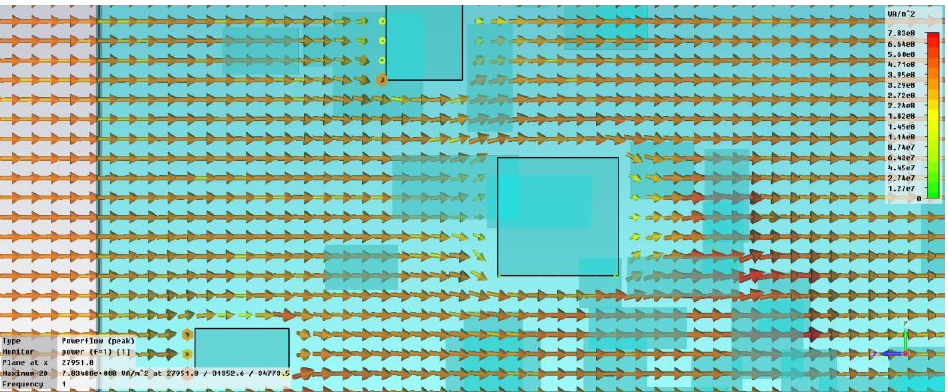
Figure 2. Power flow inside the nanocomposite. Localized shielding and localized absorption.